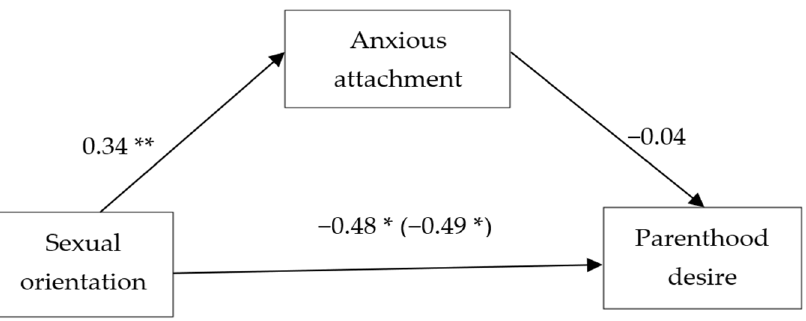
Figure 2. The mediation effect of anxious attachment on the association between sexual orientation and parenthood desire. Note. N = 789. The reported values are unstandardized regression coefficients ( B s) for the pathways between sexual orientation (0 = heterosexual, 1 = sexual minority), avoidant attachment, and parenthood desire. Gender, age, education, relationship status, and place of residence were used as covariates. The total effect of sexual orientation on parenthood desire is reported in parentheses. * p < 0.05. ** p < 0.01.